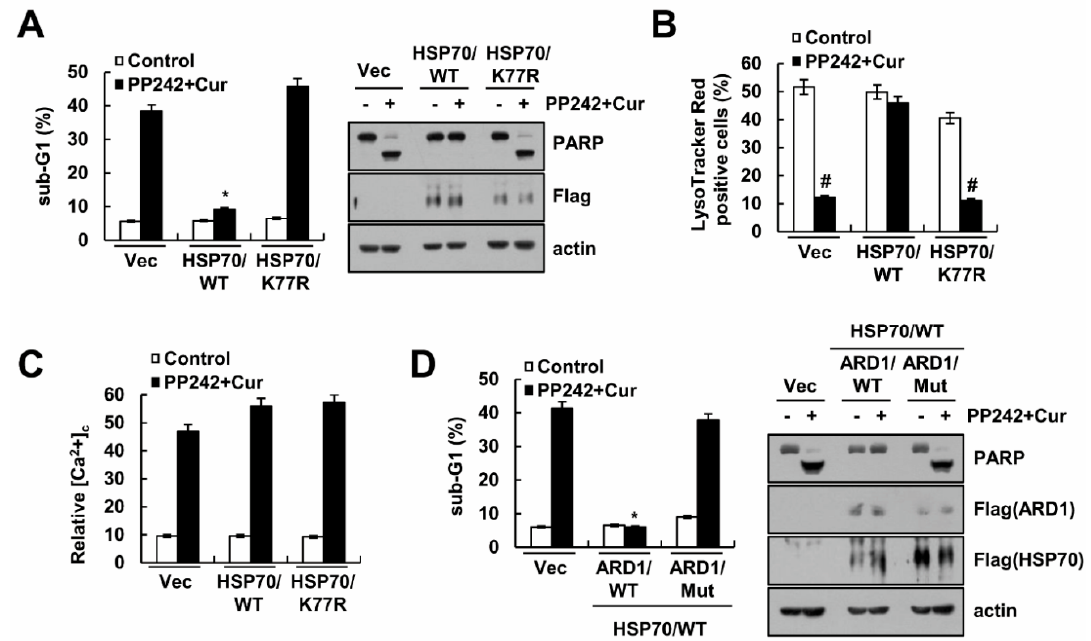
Figure 4. HSP70 acetylation inhibits PP242 plus curcumin-induced apoptosis. ( A – C ) Caki cells were transiently transfected with vector, Flag-HSP70 (WT), and mutant Flag-HSP70 (K77R) expression plasmid. After 24 h, cells were treated with 0.5 µM PP242 plus 20 µM curcumin for 30 h ( A ) and 6 h ( B , C ). Transfected cells were loaded with LysoTracker Red fluorescent dye ( B ) or Flou-4/AM fluorescent dye ( C ), and fluorescence intensities were detected by flow cytometry. ( D ) Flag-ARD1 WT and dominant negative mutant (Mut) forms were co-expressed with Flag-HSP70 (WT) in Caki cells. After 24 h, cells were treated with 0.5 µM PP242 plus 20 µM curcumin for 30 h. Flow cytometry was used to detect the sub-G1 fraction, and western blotting was used to detect the protein levels of PARP, Flag and actin. The values in ( A – D ) represent the mean ± SD of three independent samples. * p < 0.01 compared to PP242 plus curcumin-treated Vec. # p < 0.01 compared to the control.